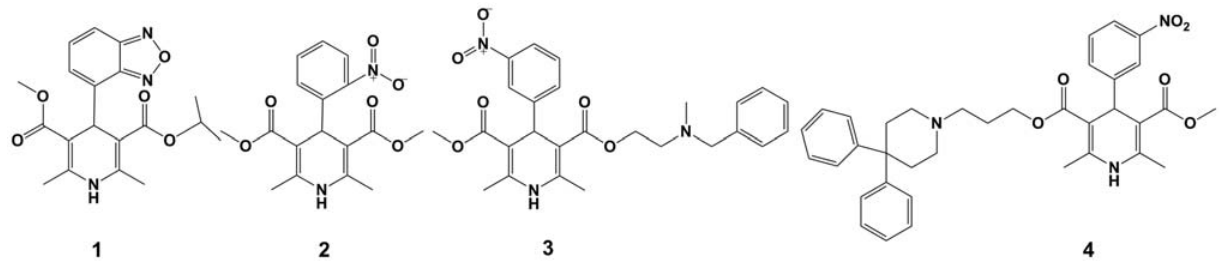
Figure 1. Some biologically important dihydropyridine